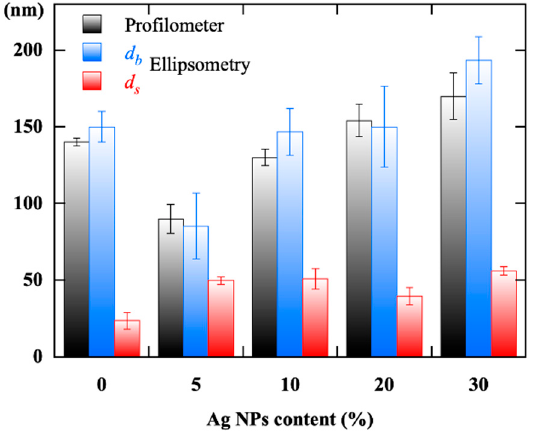
Figure 9. Thicknesses of the bulk layer ( d b ) and surface roughness ( d s ), determined by ellipsometry, and total thickness measured by a profilometer, of ZnO/Ag(NPs) nanocomposite films with different Ag NPs contents.